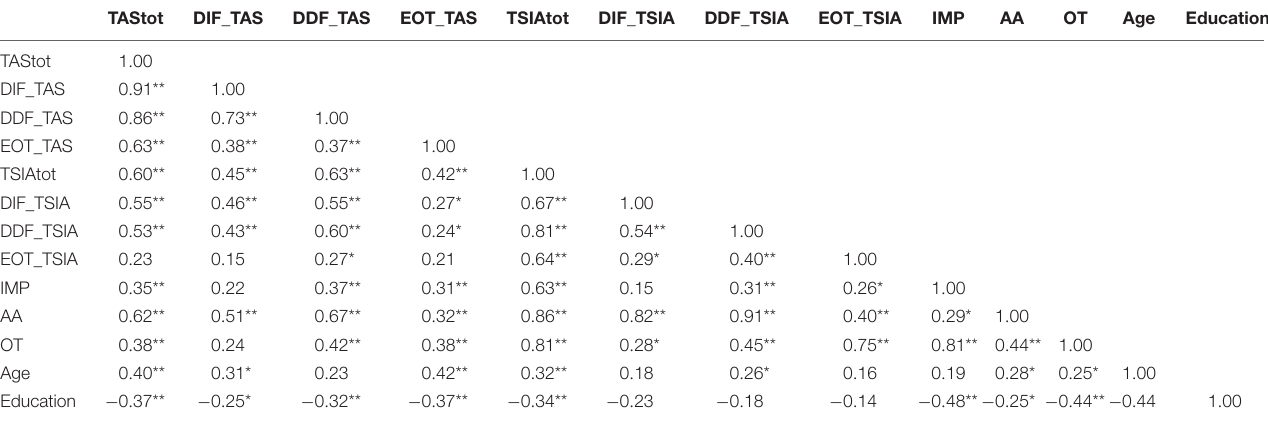
TABLE 5 | Spearman’s correlation coefficient among TAS-20 and TSIA total scores, subscales, and socio demographic